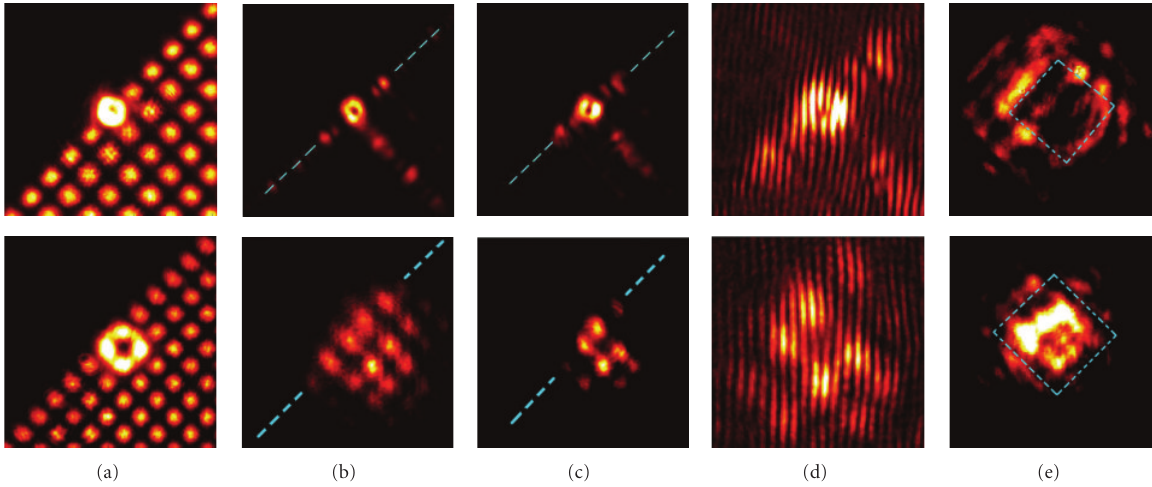
Figure 5: Experimental results of vortex self-trapping under single-site surface excitation (top) and four-site surface excitation (bottom). (a) Lattice beam superimposed with the vortex beam, (b) linear and (c) nonlinear output of the vortex beam, where blue dashed line indicates the surface location, (d) zoom-in interferogram of (c) with an inclined plane wave, and (e) k -space spectrum of (c). The dashed square in (e) marks the boundary of the first Brillouin